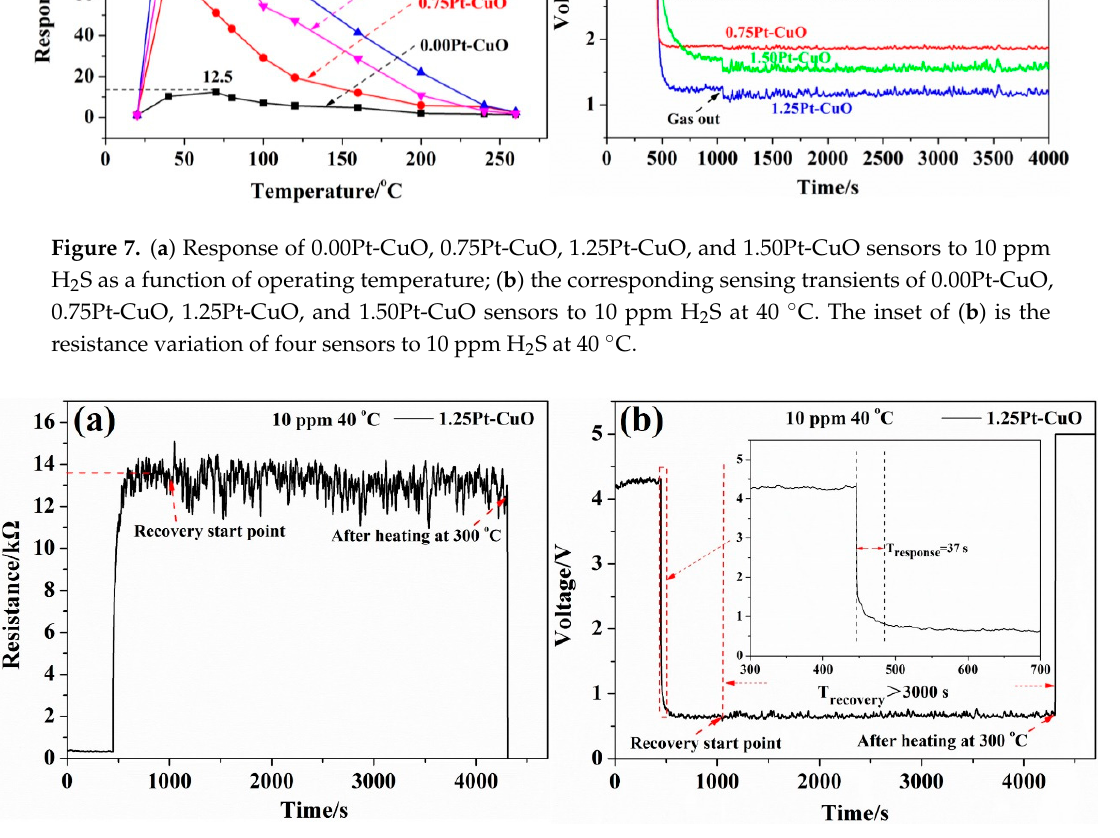
Figure 8. ( a ) The resistance variation of the 1.25Pt-CuO sensor to 10 ppm H 2 S at 40 °C; ( b ) the corresponding sensing transients of the 1.25Pt-CuO sensor. The inset of ( b ) is the magnification of sensing transients between 300 s to 700 s.